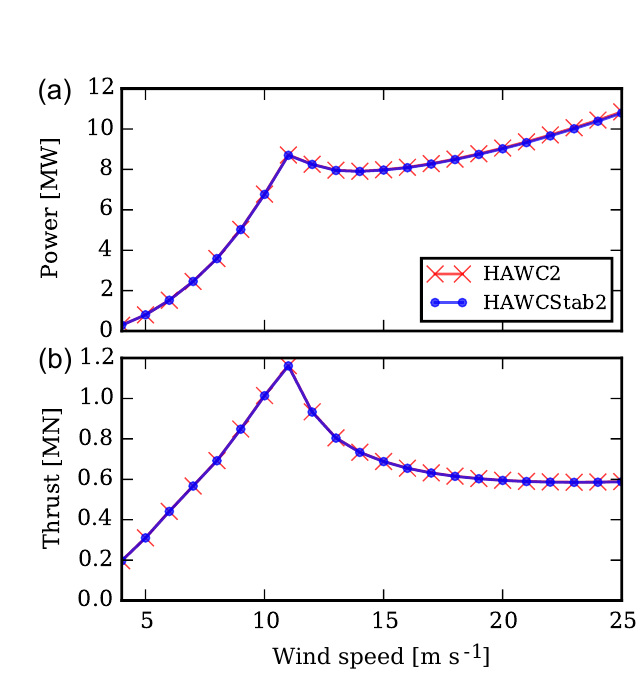
Figure 2. Power and thrust of the DTU 10MW RWT with flap– twist to feather coupled blades ( γ y = 0 . 2) obtained with HAWC2 and HAWCStab2. Note that the blades have not been pretwisted and the pitch angel has not been adjusted for this